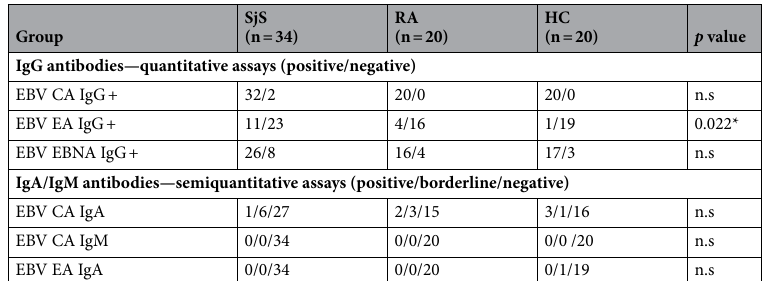
Table 2. EBV serological evaluation in SjS, RA and HC. Results for the different anti-EBV antibodies in the different patient groups (positive/negative for quantitative assays; positive/borderline/negative for